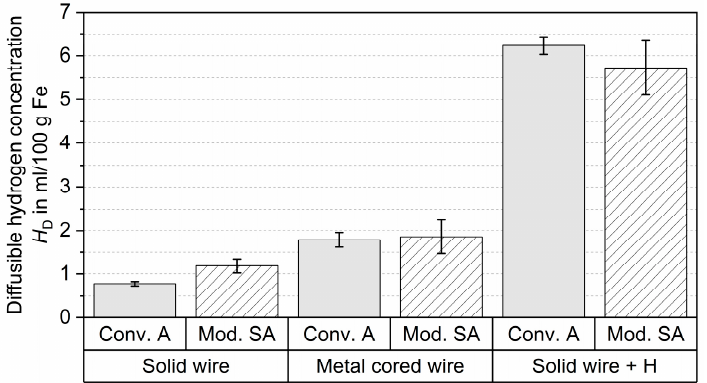
Figure 4. Diffusible hydrogen concentration H D in the arc weld metal for the different used filler materials and arc processes determined according to ISO 3690; “+ H” is with shielding gas mixture containing 0.5% H 2 .